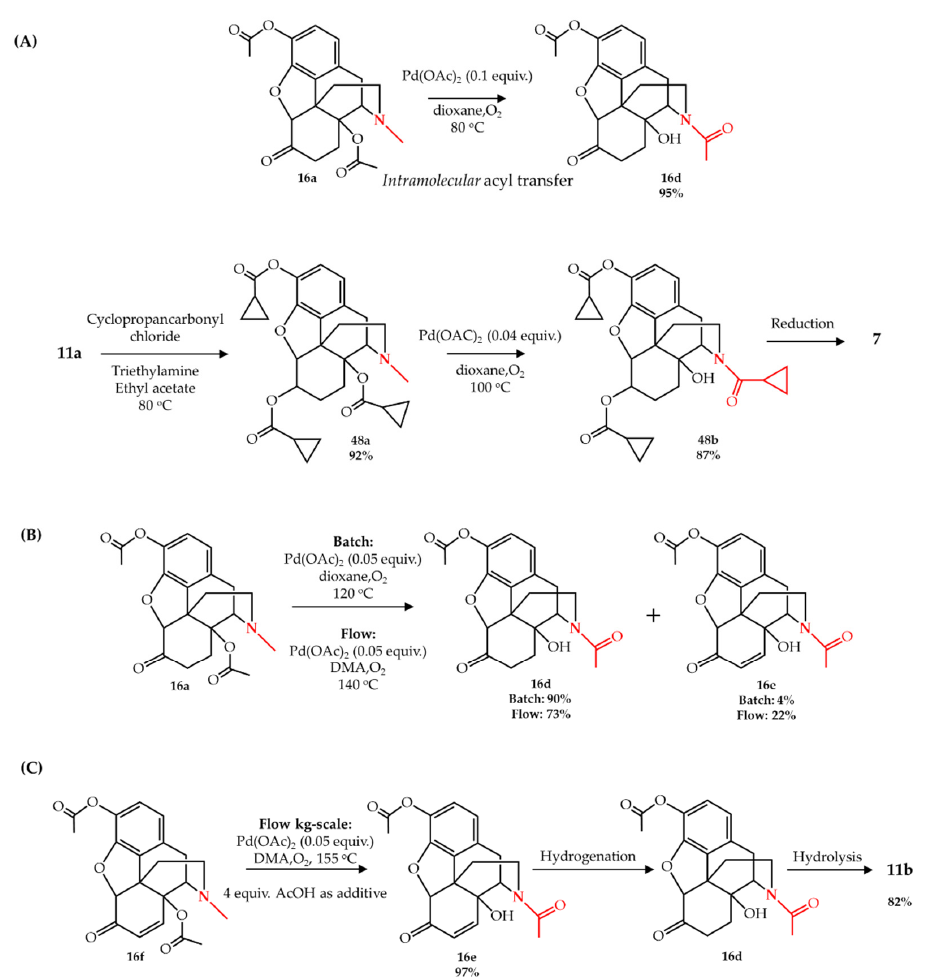
Figure 7. Pd-catalyzed intramolecular acyl transfer in opiates: ( A ) conversion of 3,14-diacetate oxymorphone ( 16a) according to Machara et al. [67], ( B ) conversion of 16a according to Gutmann et al. [68], and ( C ) conversion of 16f , the hydrogenated form of 16a , according to Gutmann et al. [68].